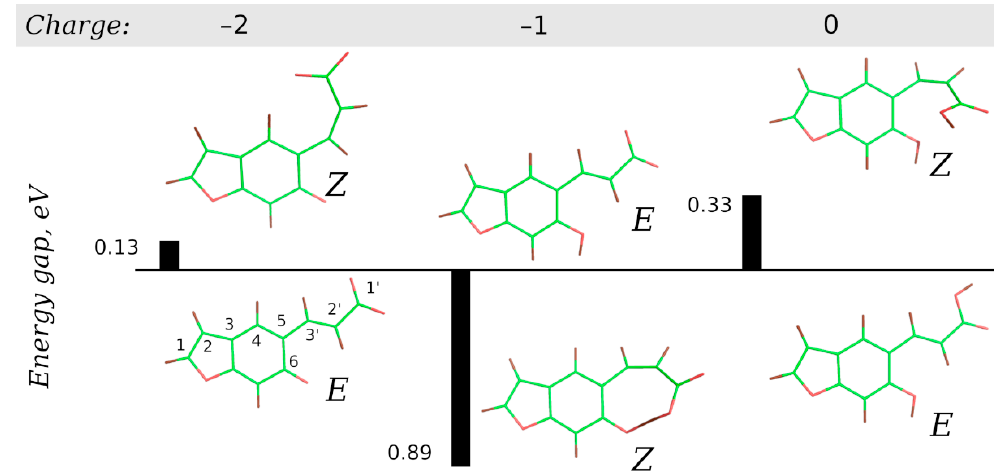
Figure 6. Optimized geometries for the dianionic, monoanionic, and protonated forms of ( Z/E )-FCAs (with charges of − 2, − 1, and 0, respectively). Bars represent energy gaps (eV) between corresponding forms of E -FCA and Z -FCA.